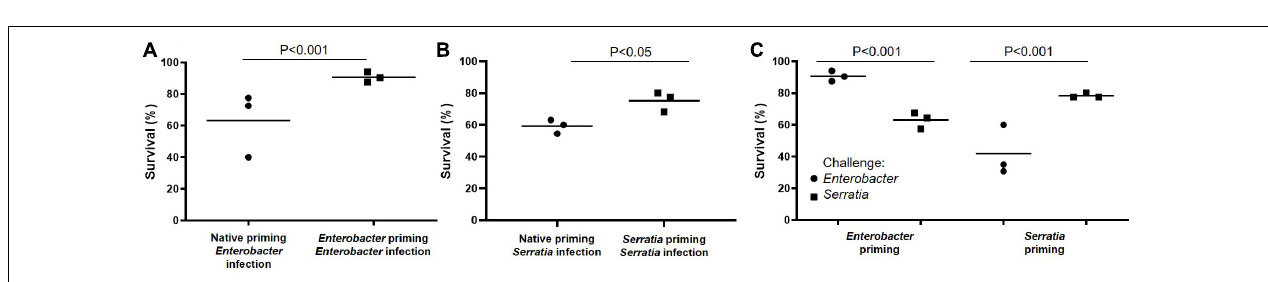
FIGURE 2 | Bacterial infection resulted in mortality. Naive mosquitoes were infected with Serratia or Enterobacter by intrathoracical injection. Sterile water injection was used as injury control. The average survival was generated from three replicates. Each replicate had 40 females. The survival was significantly reduced by Serratia and Enterobacter infection in comparison with injury, tested using Chi square.